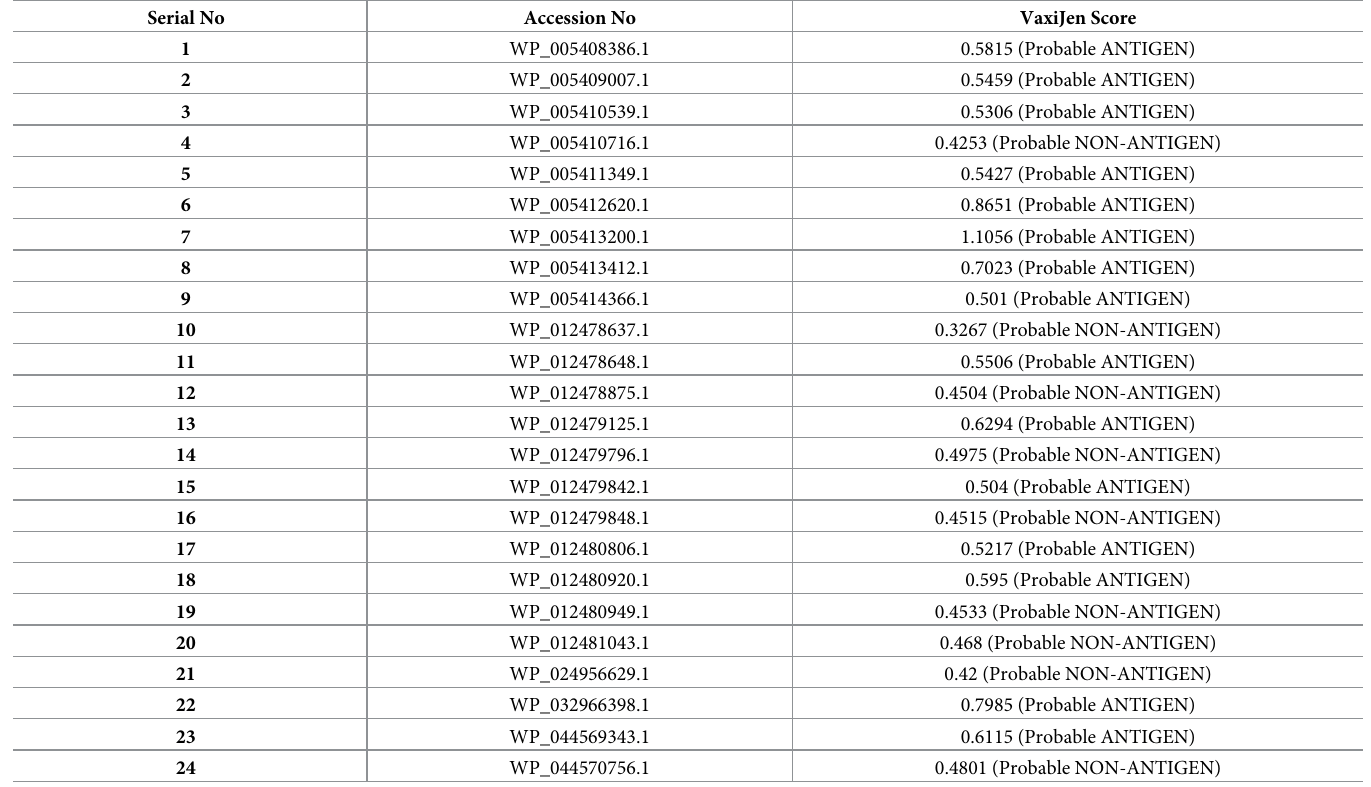
Table 4. The antigenic properties determination using the VaxiJen